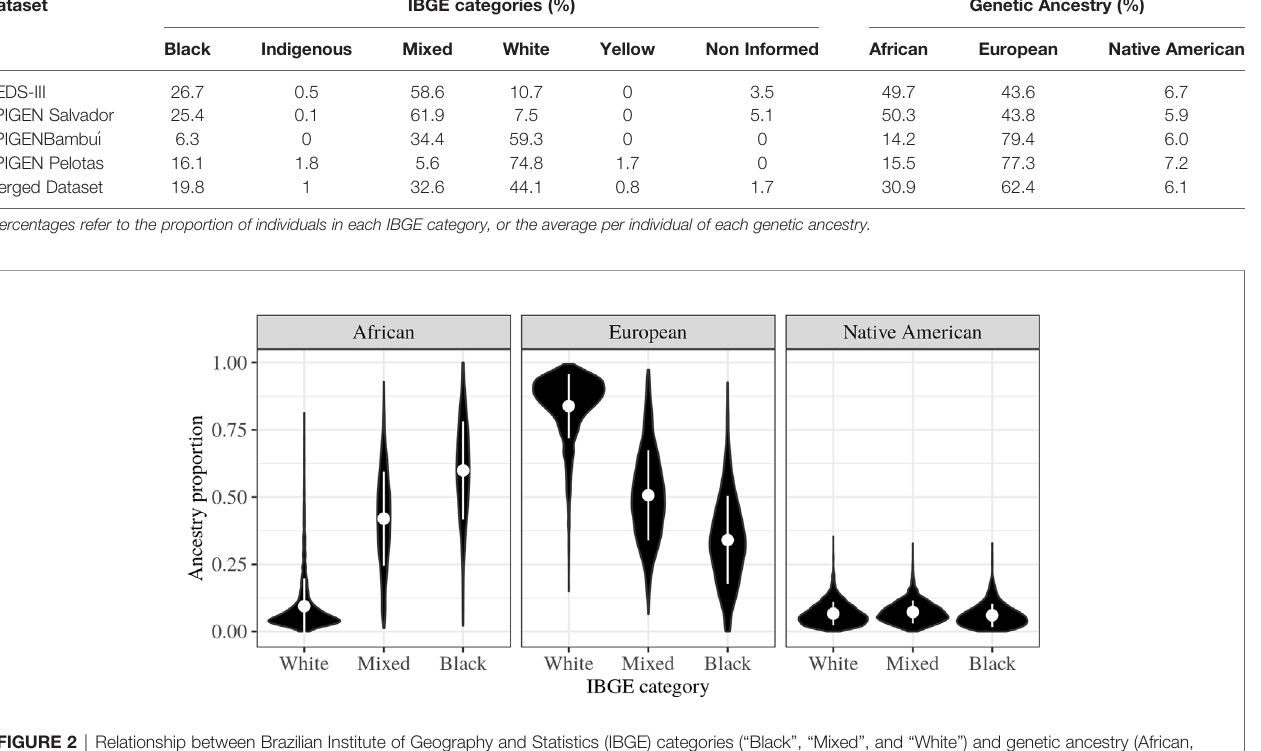
TABLE 1 | Brazilian Institute of Geography and Statistics (IBGE) categories and genetic ancestry across cohorts. * Dataset